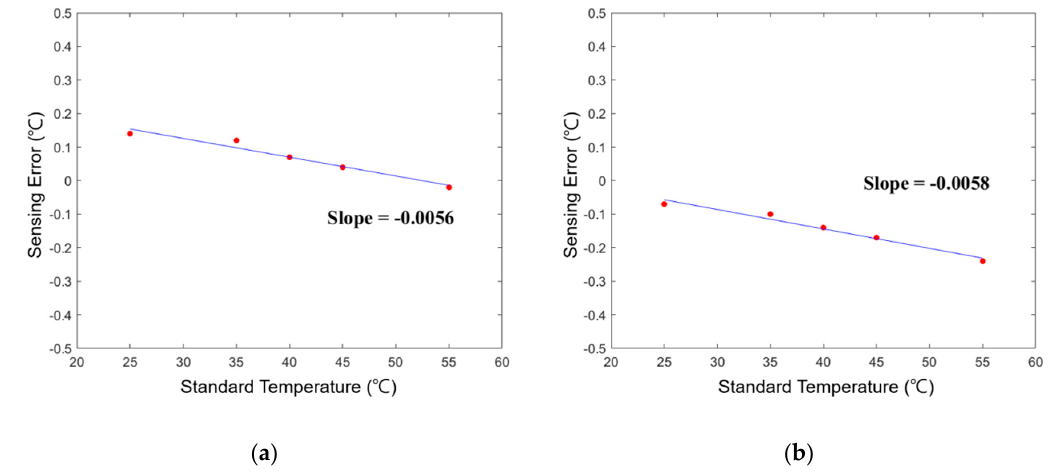
Figure 6. The sensing error of the TSWTM at various temperatures: ( a ) CH1; ( b ) CH2.